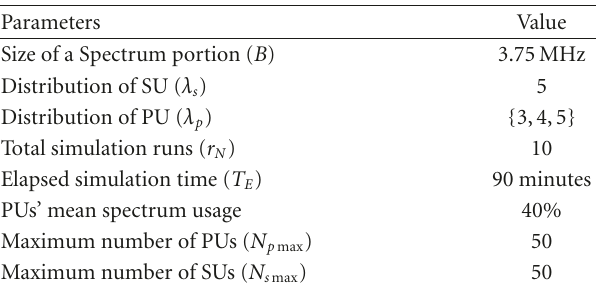
Table 4: Fixed values of